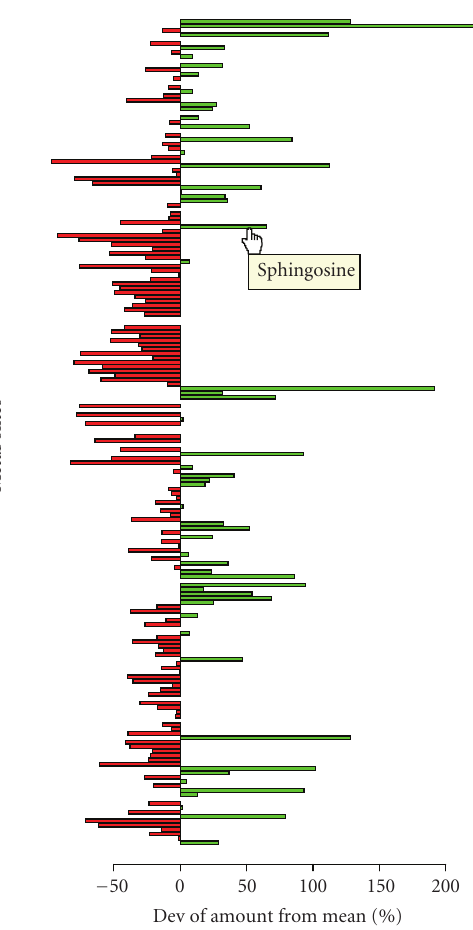
Figure 3: Examples for output generated by meta P- server : sample barplot with green color denoting high and red color denoting low concentration of the respective metabolite relative to the mean